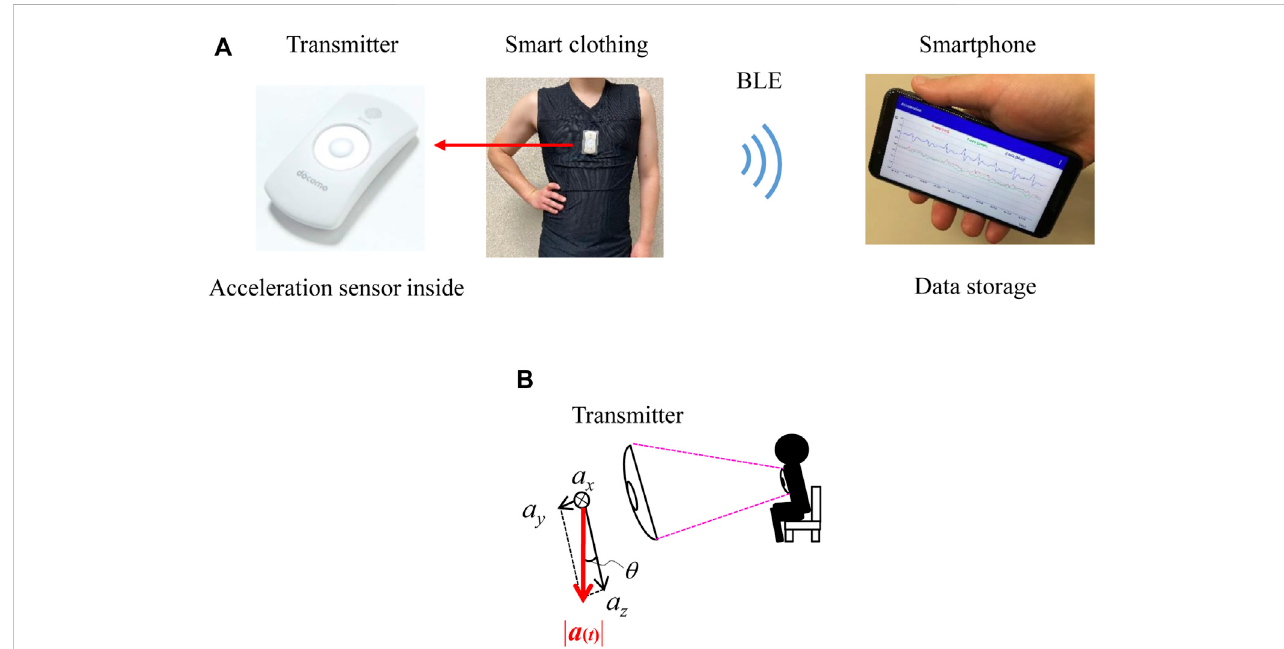
FIGURE 1 Experimental setup. (A) Experimental setup comprised a smartphone and smart clothing with a transmitter. (B) Direction of each axis of